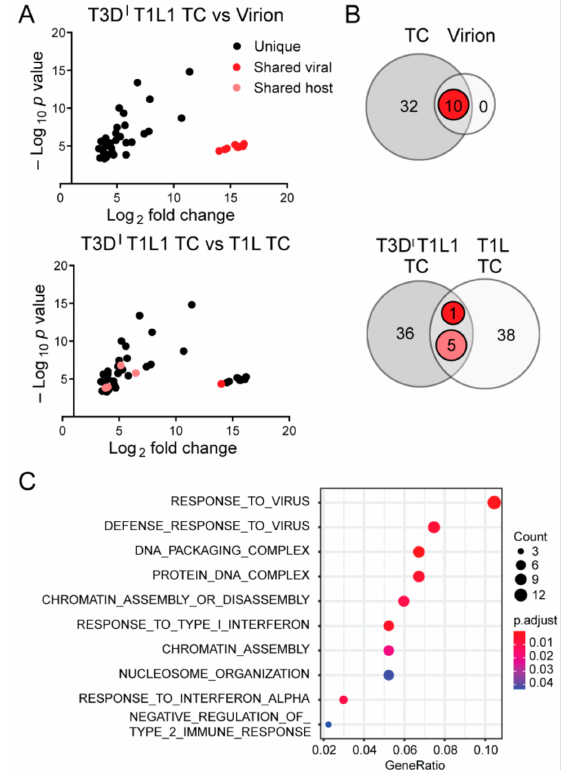
Figure 5. rsT1L TC particle host RNA packaging specificity is largely independent of the viral RdRp. ( A ) Graphs showing host genes packaged by rsT3D I T1L1 TC particles that have a p value < 0.01 and fold change > 8 compared with mock TC. Red and pink indicate shared viral and host genes, respectively, between rsT3D I T1L1 TC and virions (upper) or rsT1L TC (lower). ( B ) Venn diagrams showing overlap in host genes with a p value < 0.01 and fold change > 8 between rsT3D I T1L1 TC and virions (upper) or between rsT3D I T1L1 TC and rsT1L TC (lower). Red indicates shared viral genes, and pink indicates shared host genes. ( C ) Gene set overrepresentation analysis with GO terms for host genes packaged by rsT3D I T1L1 TC. The p value is indicated by circle color, and transcript count is indicated by circle size, as shown in the